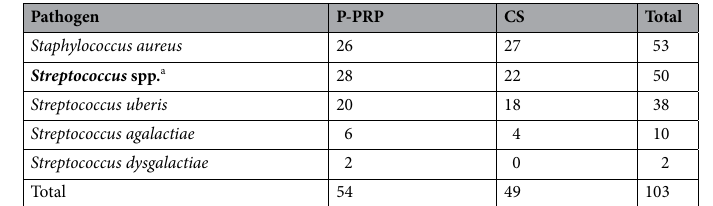
Table 2. Frequency of isolated pathogens in the 103 subclinical mastitis cases at the enrollment in the study (time zero). CS cefquinome sulfate, P-PRP pure platelet rich plasma. a Includes only Streptococcus uberis , Streptococcus agalactiae and Streptococcus dysgalactiae .